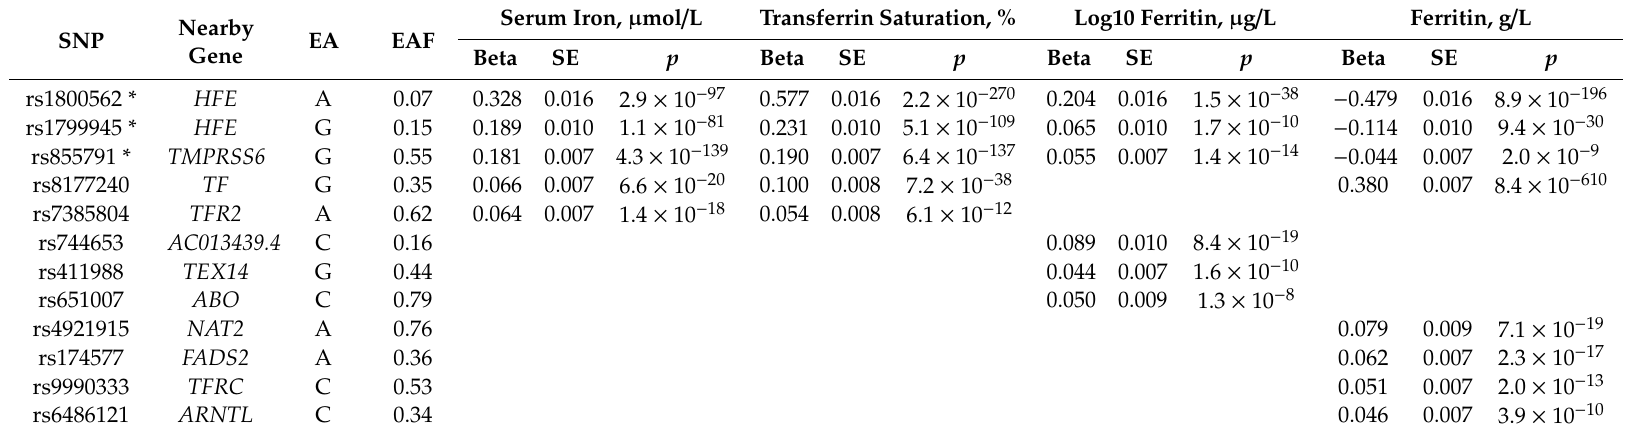
Table 1. SNPs associated with iron status biomarkers at genome-wide significance level and included in the main analyses with three primary SNPs and secondary analyses of all